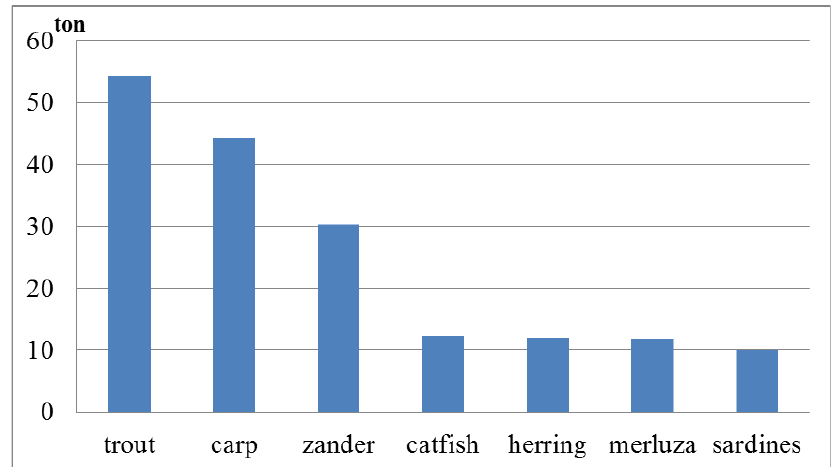
Fig. 4. The export of frozen fish of Ukraine in 2018, tons